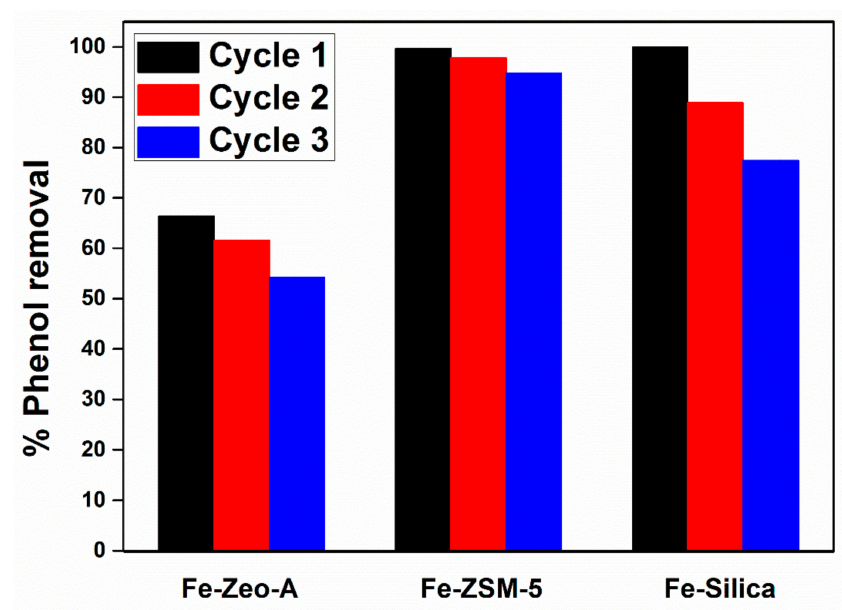
Figure 15. Reusability of Fe-based catalysts for phenol